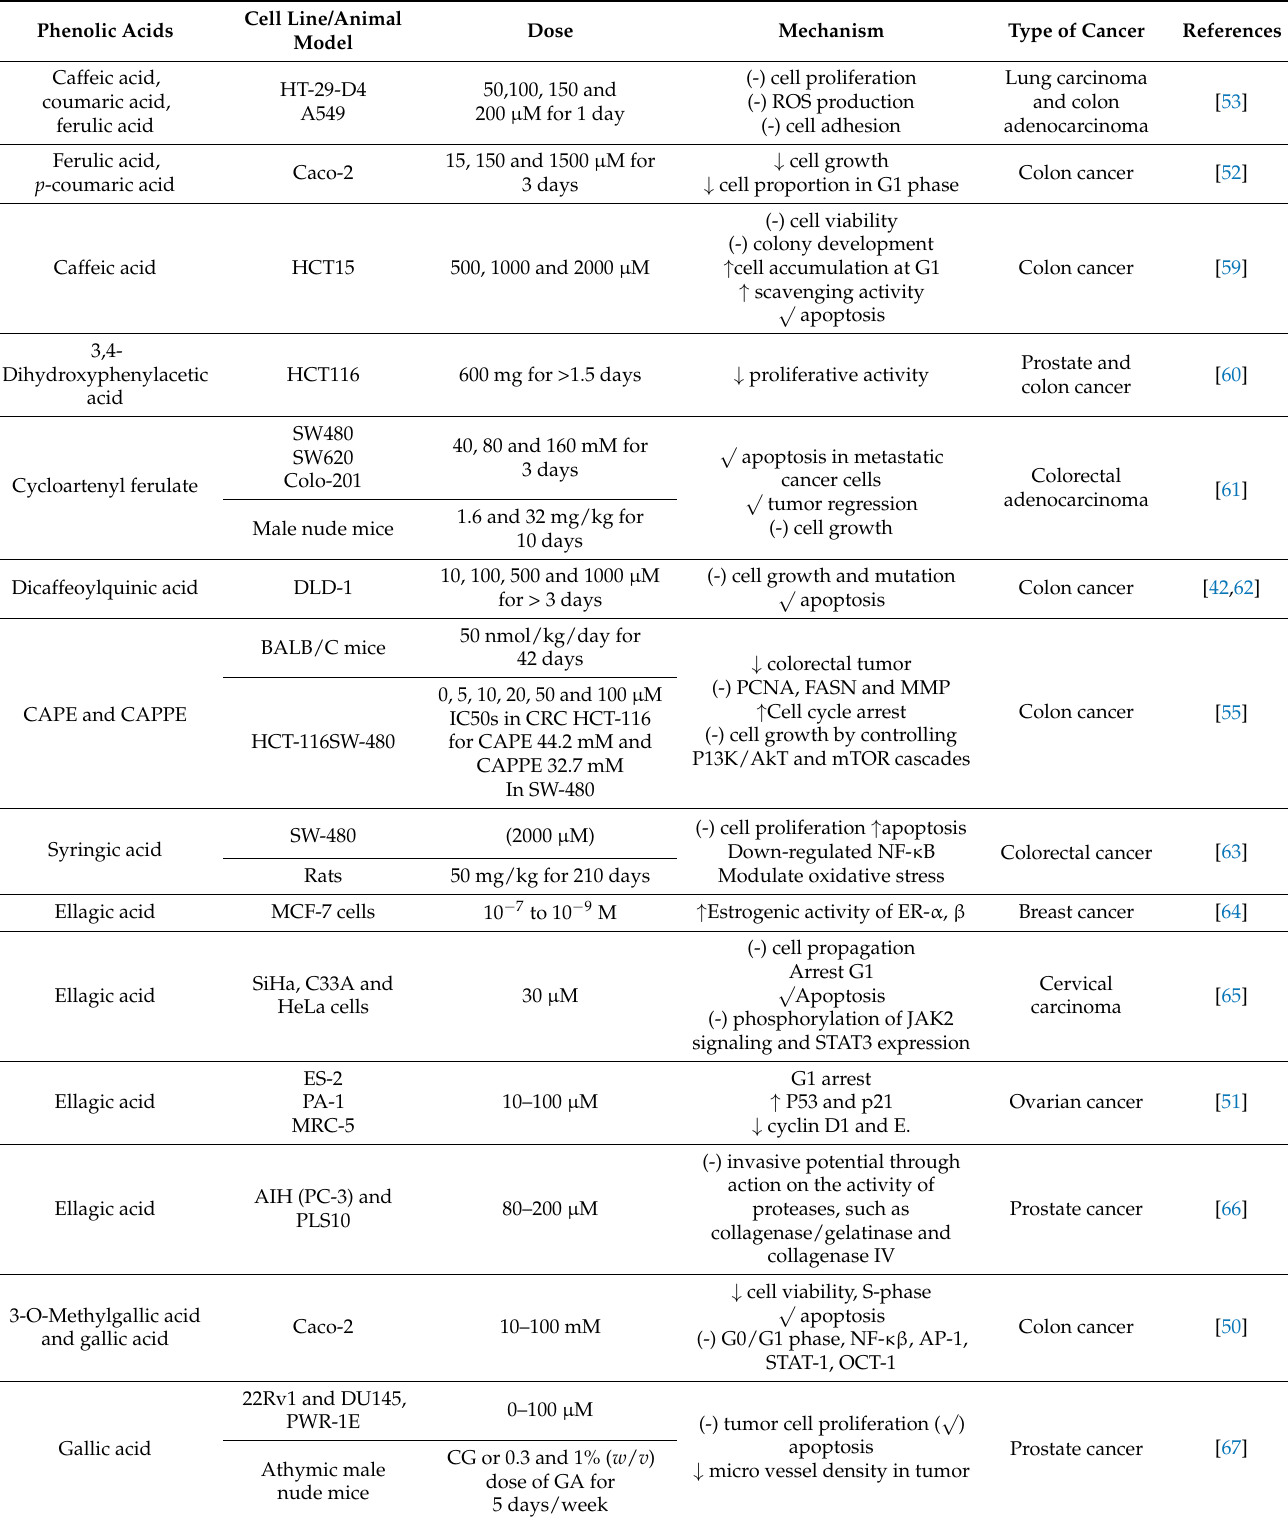
Table 2. Anticancer activity of phenolic